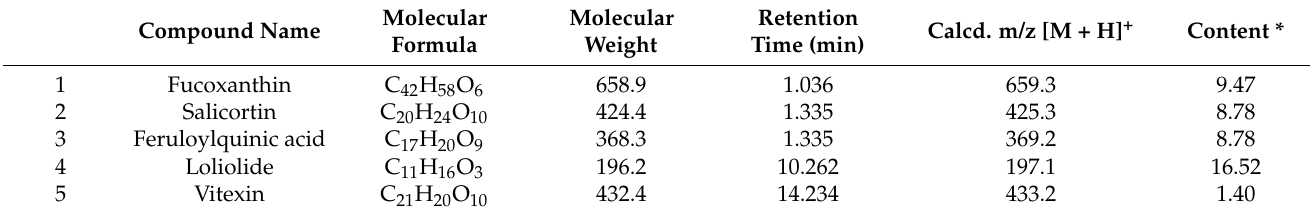
Table 1. Representative LC-MS chromatogram of S. horneri